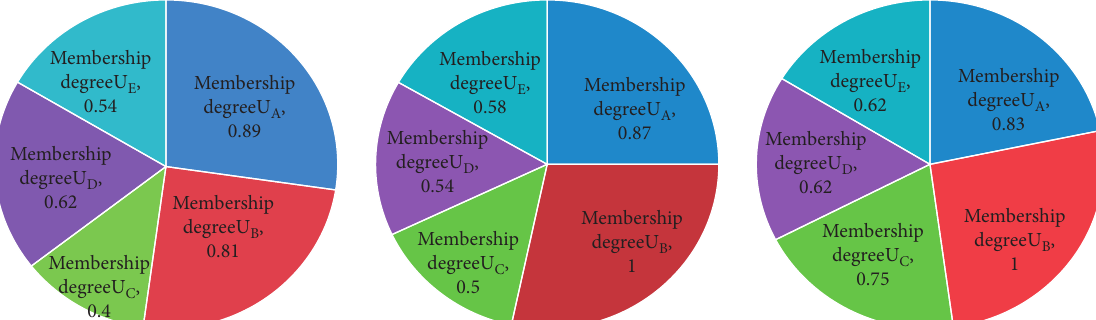
A value in 2011.